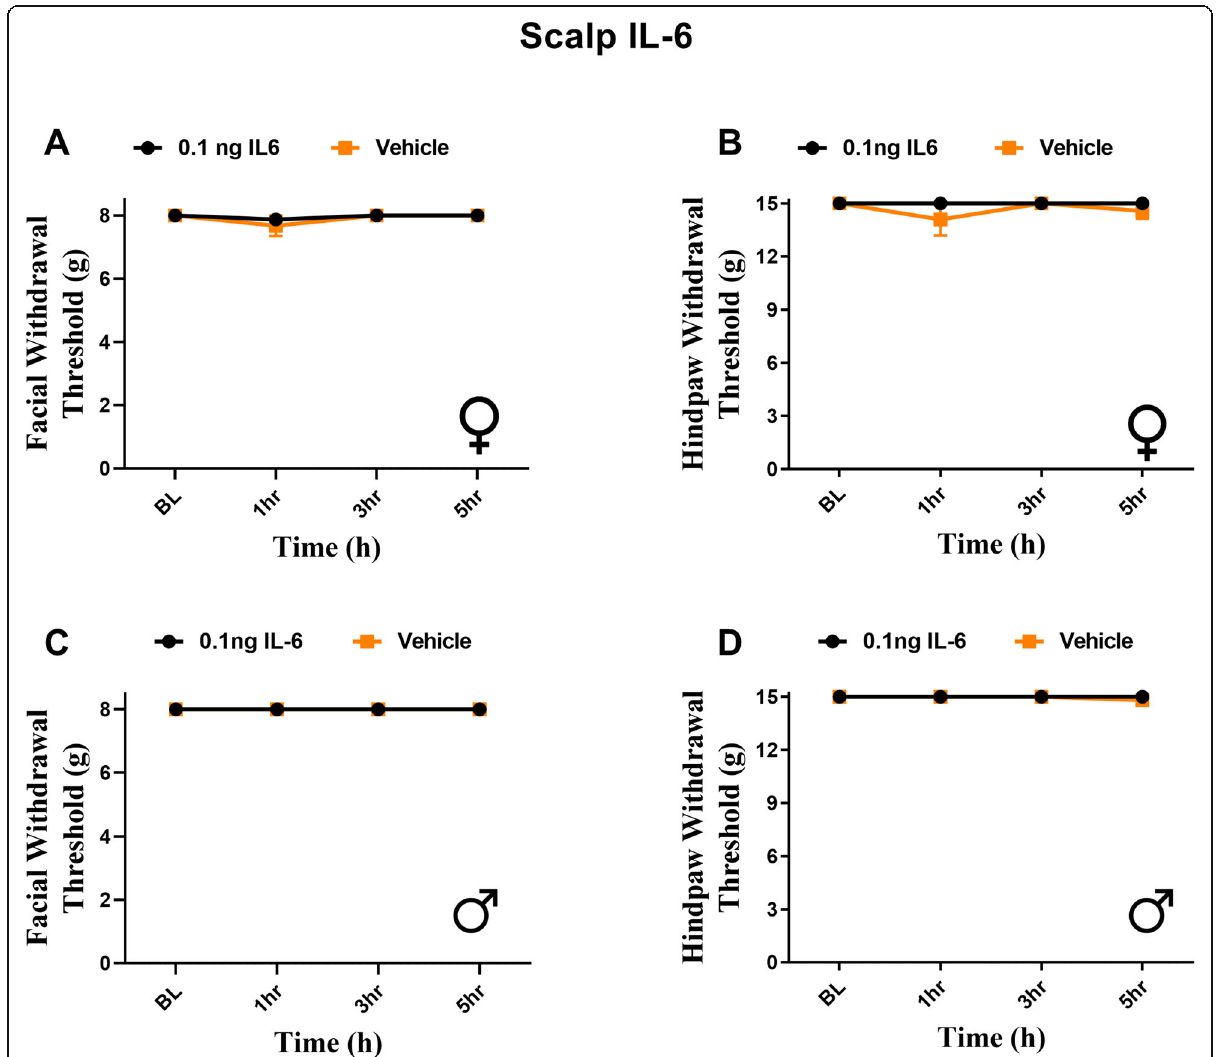
Fig. 4 Subcutaneous injection of IL-6 in the scalp produces no significant facial or hindpaw responses in male and female rats. Rats had facial and hindpaw withdrawal thresholds assessed to establish baseline withdrawal thresholds, as well as following administration of 0.1 ng IL-6 (6 females, 8 males) or vehicle (7 females, 6 males) subcutaneously in the scalp. Two-way ANOVA followed by Bonferroni posthoc analysis revealed no significant facial or hindpaw responses in female ( A , B ) (F (1, 44) = 0.2761, p = 0.6019) (F (1, 44) = 1.502, p = 0.2269) or male ( C , D ) (no variation among groups) (F (1, 48) = 1.371, p = 0.2473)